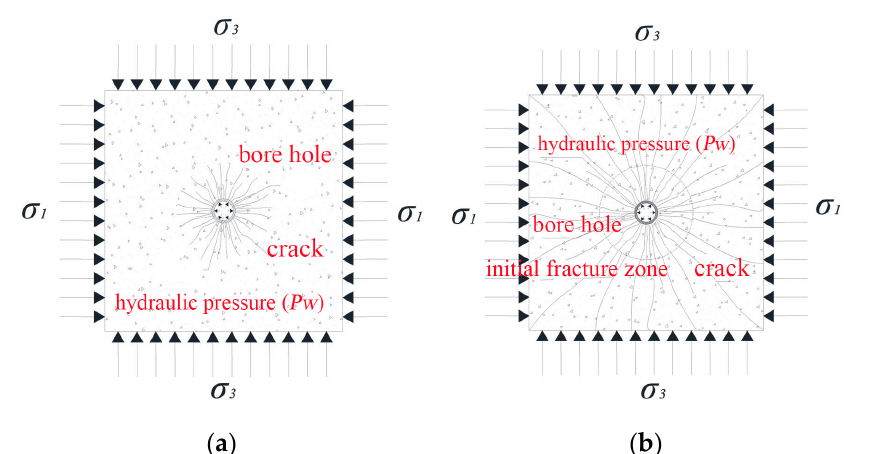
( b ) Figure 10. Schematic diagram of coal and rock mass cracking step by step under cyclic load. ( a ) In- itial fracturing; ( b ) Extended fracturing. 4.3. Experimental Results 4.3.1. The Law of Crack Expansion Energy under Monotonic Loading By applying a monotonic load, the change rule of crack AE signal was monitored, and the crack initiation pressure and crack development characteristics of concrete specimens under monotonic load were analyzed. The monotonic load cracking diagram is shown in Figure 11.